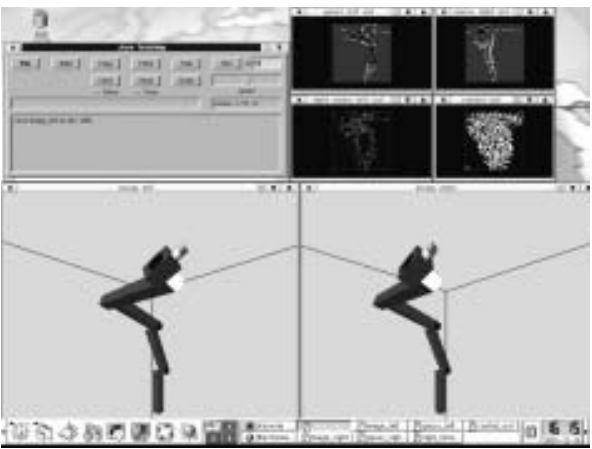
Figure 2 MAE screenshot of a simple neural architecture.